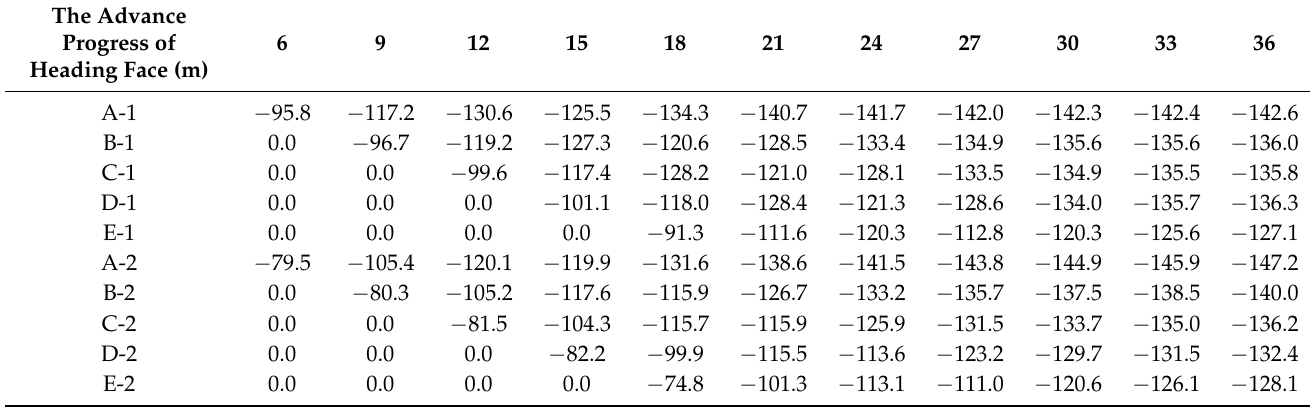
Table 13. Axial force trend of the first-layer steel support (Unit: